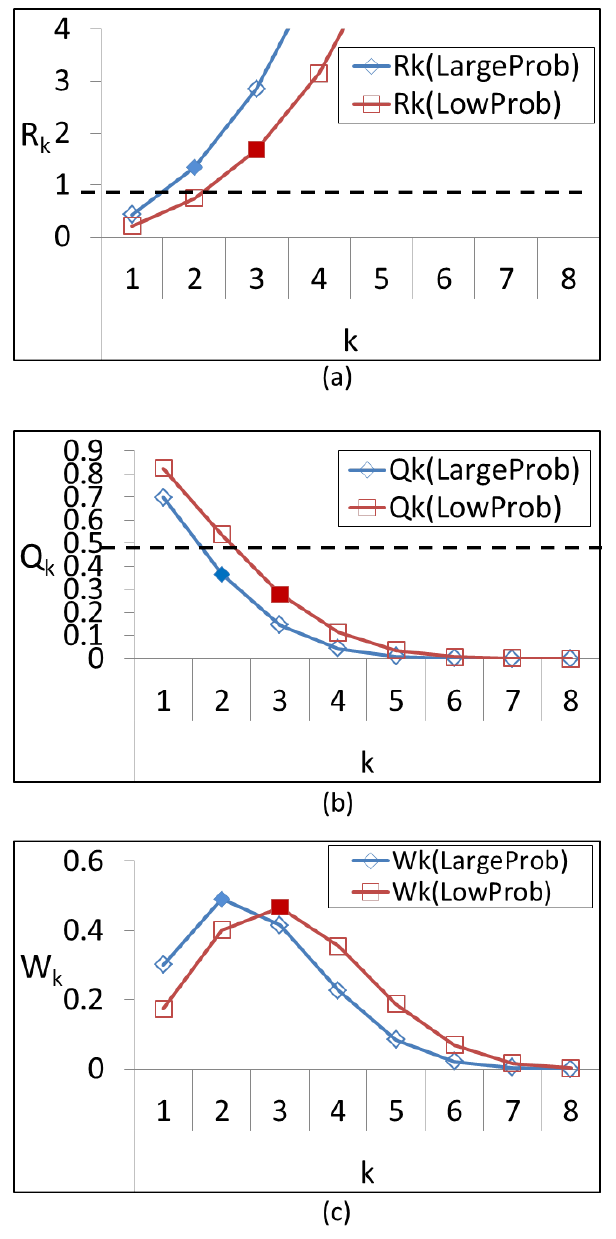
Figure 5. Output of odds algorithm on two examples. ( a ): Plot of R k . ( b ): Plot of Q k . ( c ): Plot of W k . Due to odds’s algorithm simplicity and recall avoidance behaviour, it will be applied on the probability of intra modes to reduce the complexity of